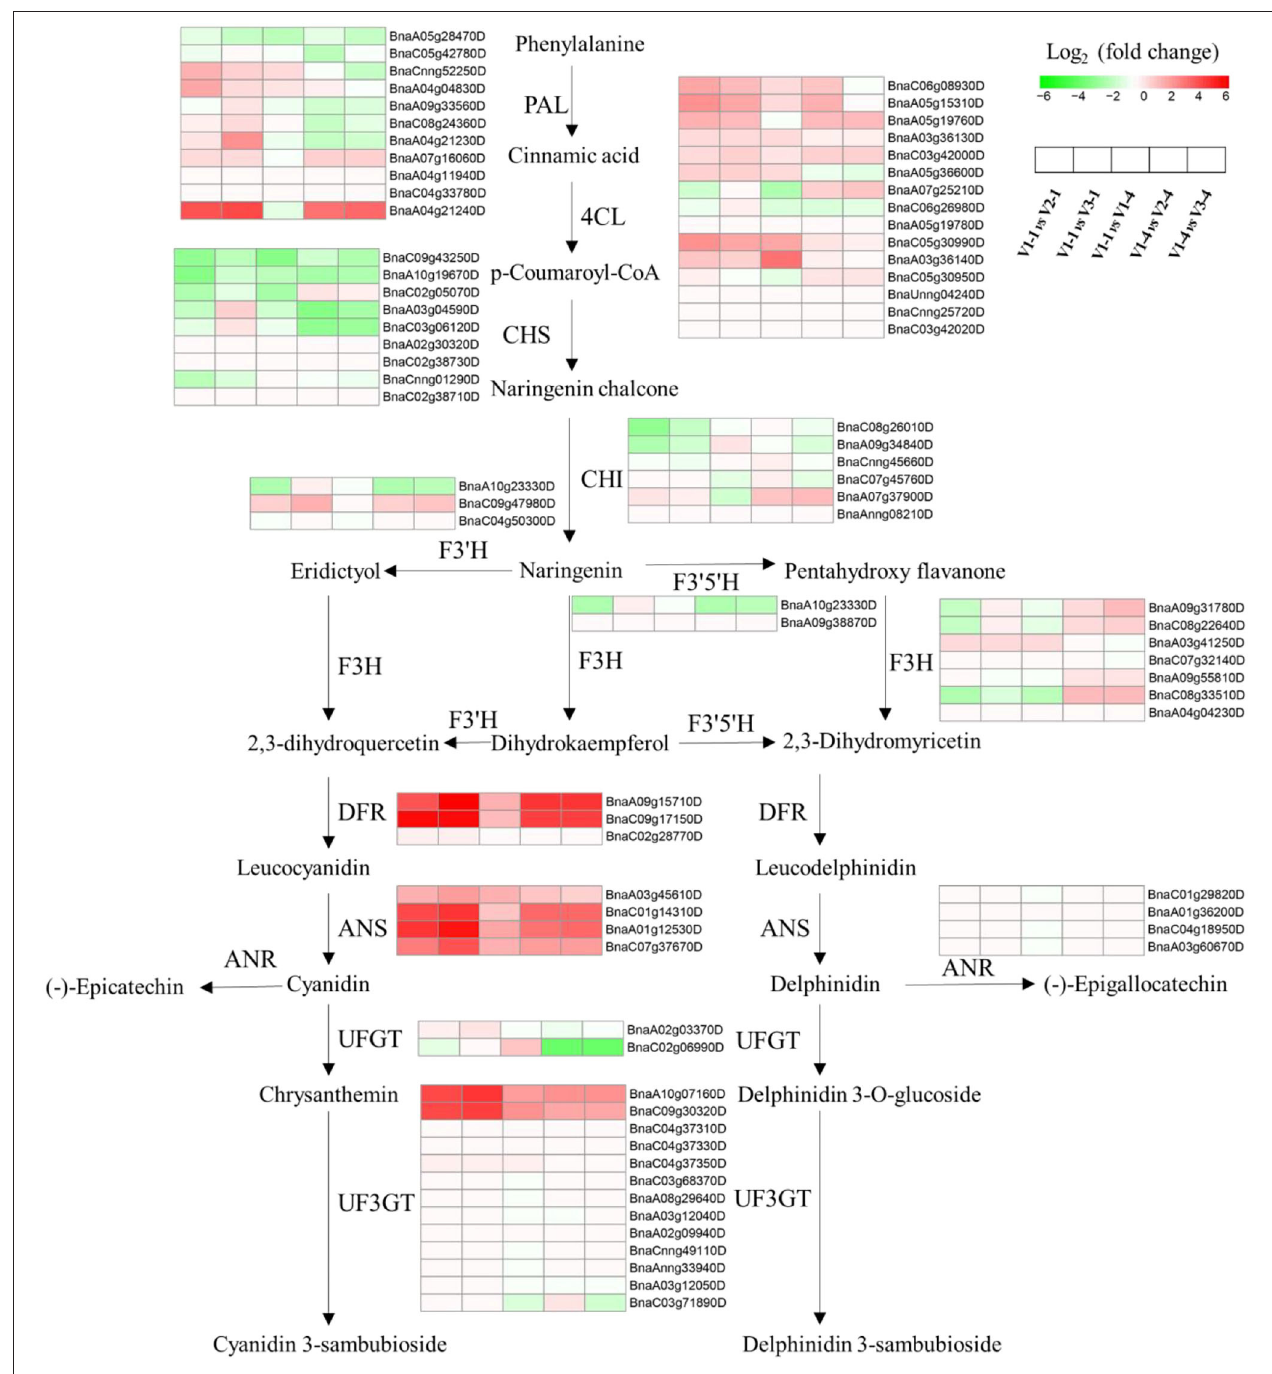
FIGURE 5 | Overview of the transcriptional regulation of anthocyanin biosynthetic genes. Heatmaps represent the log 2 -fold change value of V1-1 vs. V2-1, V1-1 vs. V3-1, V1-1 vs. V1-4, V1-3 vs. V2-4, and V1-4 vs. V3-4, respectively. PAL, phenylalanine ammonia lyase; 4CL, 4-coumarate co ligase; CHS, chalcone synthase; CHI, chalcone isomerase; F3’H, flavonoid 3’-hydroxylase; F3H, flavanone 3-hydroxylase; F3’5’H, flavonoid-3’5’-hydroxylase; DFR, dihydroflavonol reductase; ANS, anthocyanidin synthase; ANR, anthocyanidin reductase; UFGT, uridine diphosphate glucose-flavonoid glucosyltransferase; UF3GT, UDP: flavonoid